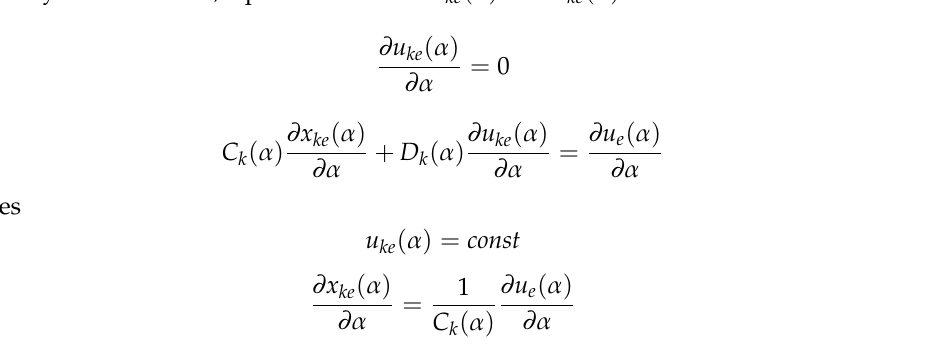
Figure 7. Step responses with a scheduled PI controller: case 2.